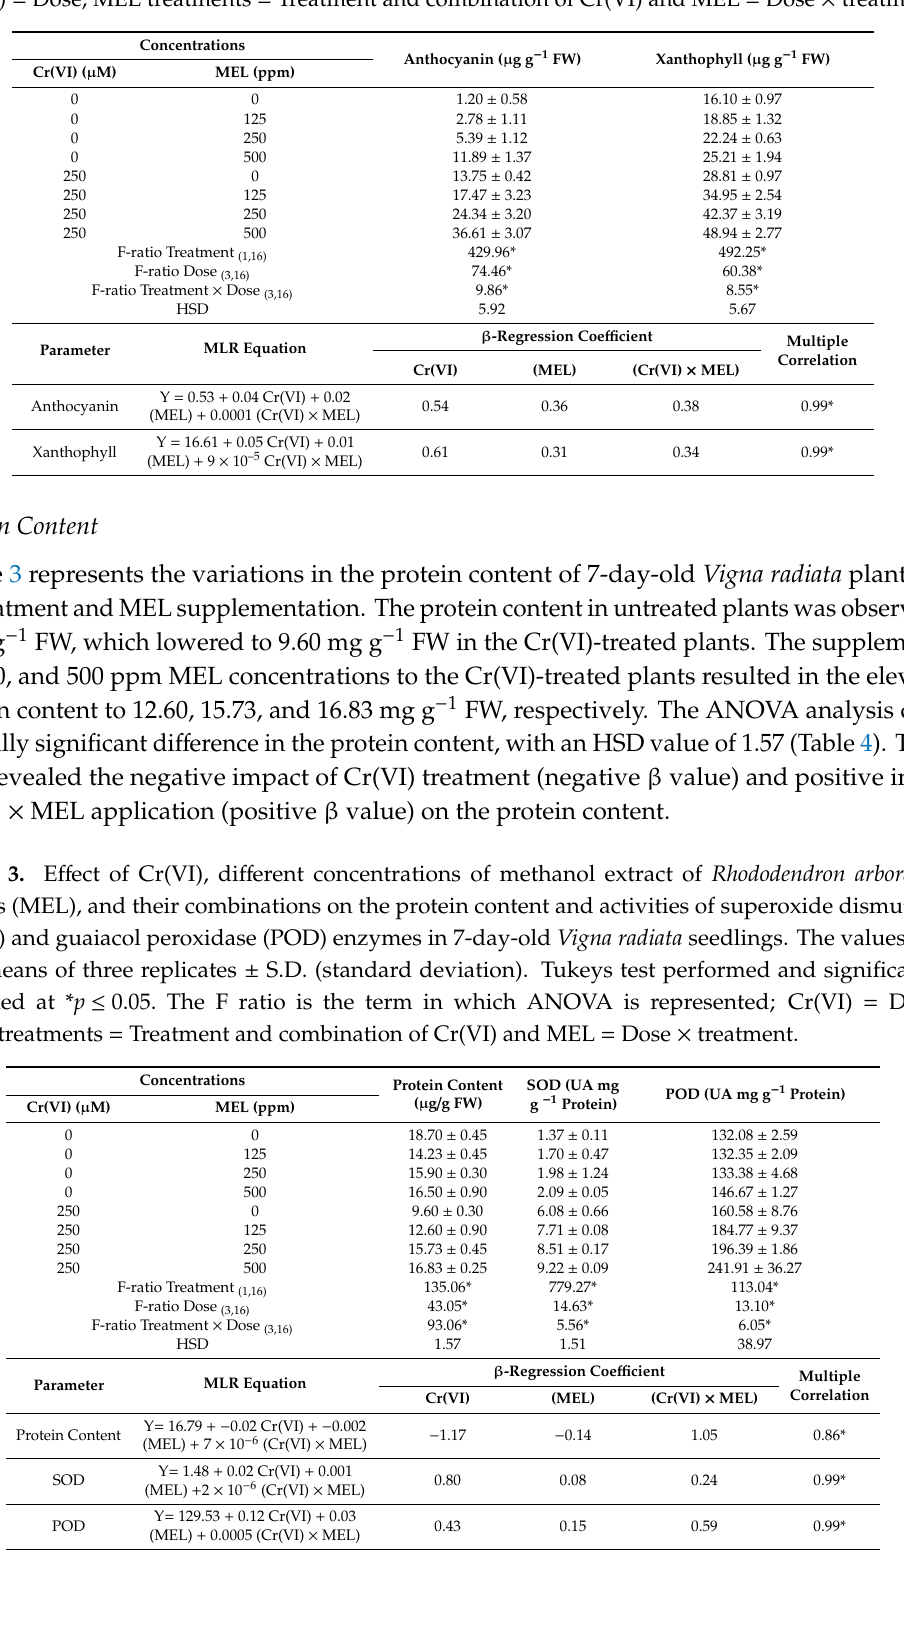
Table 2. E ff ect of Cr(VI), di ff erent concentrations of methanol extract of Rhododendron arboreum leaves (MEL), and their combinations on anthocyanin and xanthophyll content in 7-day-old Vigna radiata seedlings. The values are the means of three replicates ± S.D. (standard deviation). Tukeys test performed and significance checked at * p ≤ 0.05. the F ratio is the term in which ANOVA is represented; Cr(VI) = Dose, MEL treatments = Treatment and combination of Cr(VI) and MEL = Dose × treatment.